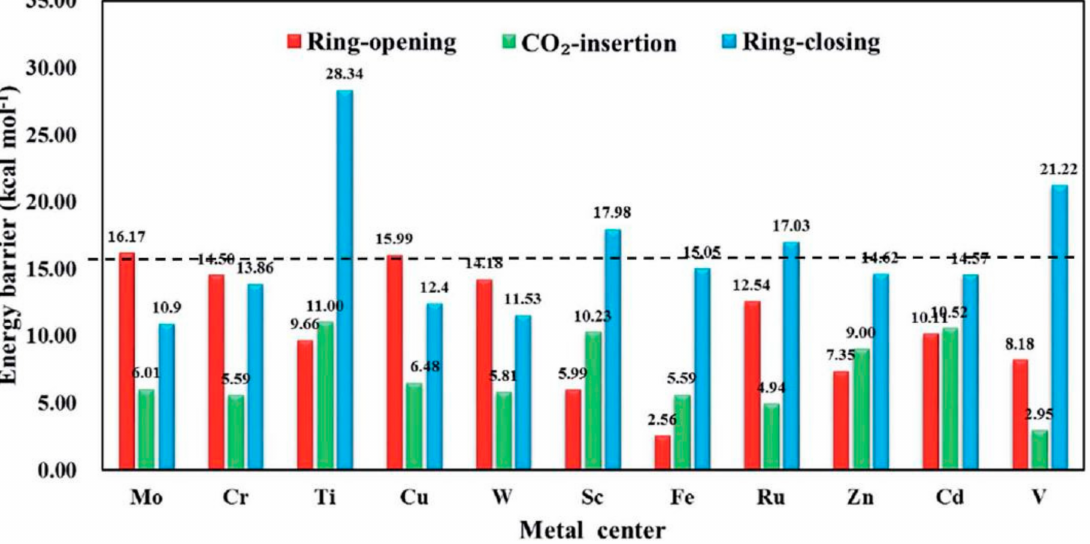
Figure 30. Gibbs energy barrier for CO 2 cycloaddition with PO using M-HKUST-1 as a catalyst. Reprinted with permission from Ref. [133]. Copyright 2019 Royal Society of